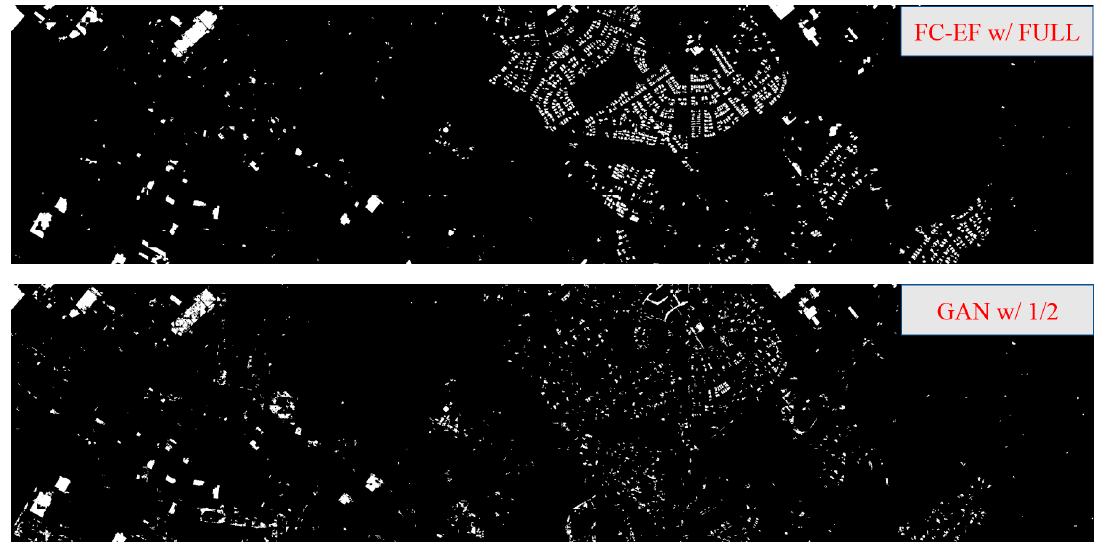
Figure 12. Change detection results of di ff erent methods on the whole test area. From top to bottom: 2011 and 2016 images; label with 1715 truly changed buildings; results of our method (Mask R-CNN) without change samples; our method (Mask R-CNN) fine-tuned on half of the change samples (green box in Figure 10); FC-EF trained on half of the samples; FC-EF trained on all of the samples; GAN-based method trained on half of the samples. We did not list the results of our methods with the MS-FCN and the results with all of the samples because the former looks the same as with the Mask R-CNN, and the latter looks the same as with half